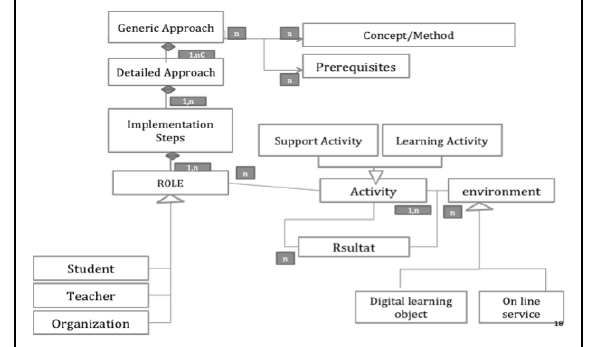
Fig. 4. IMS-LD proposed